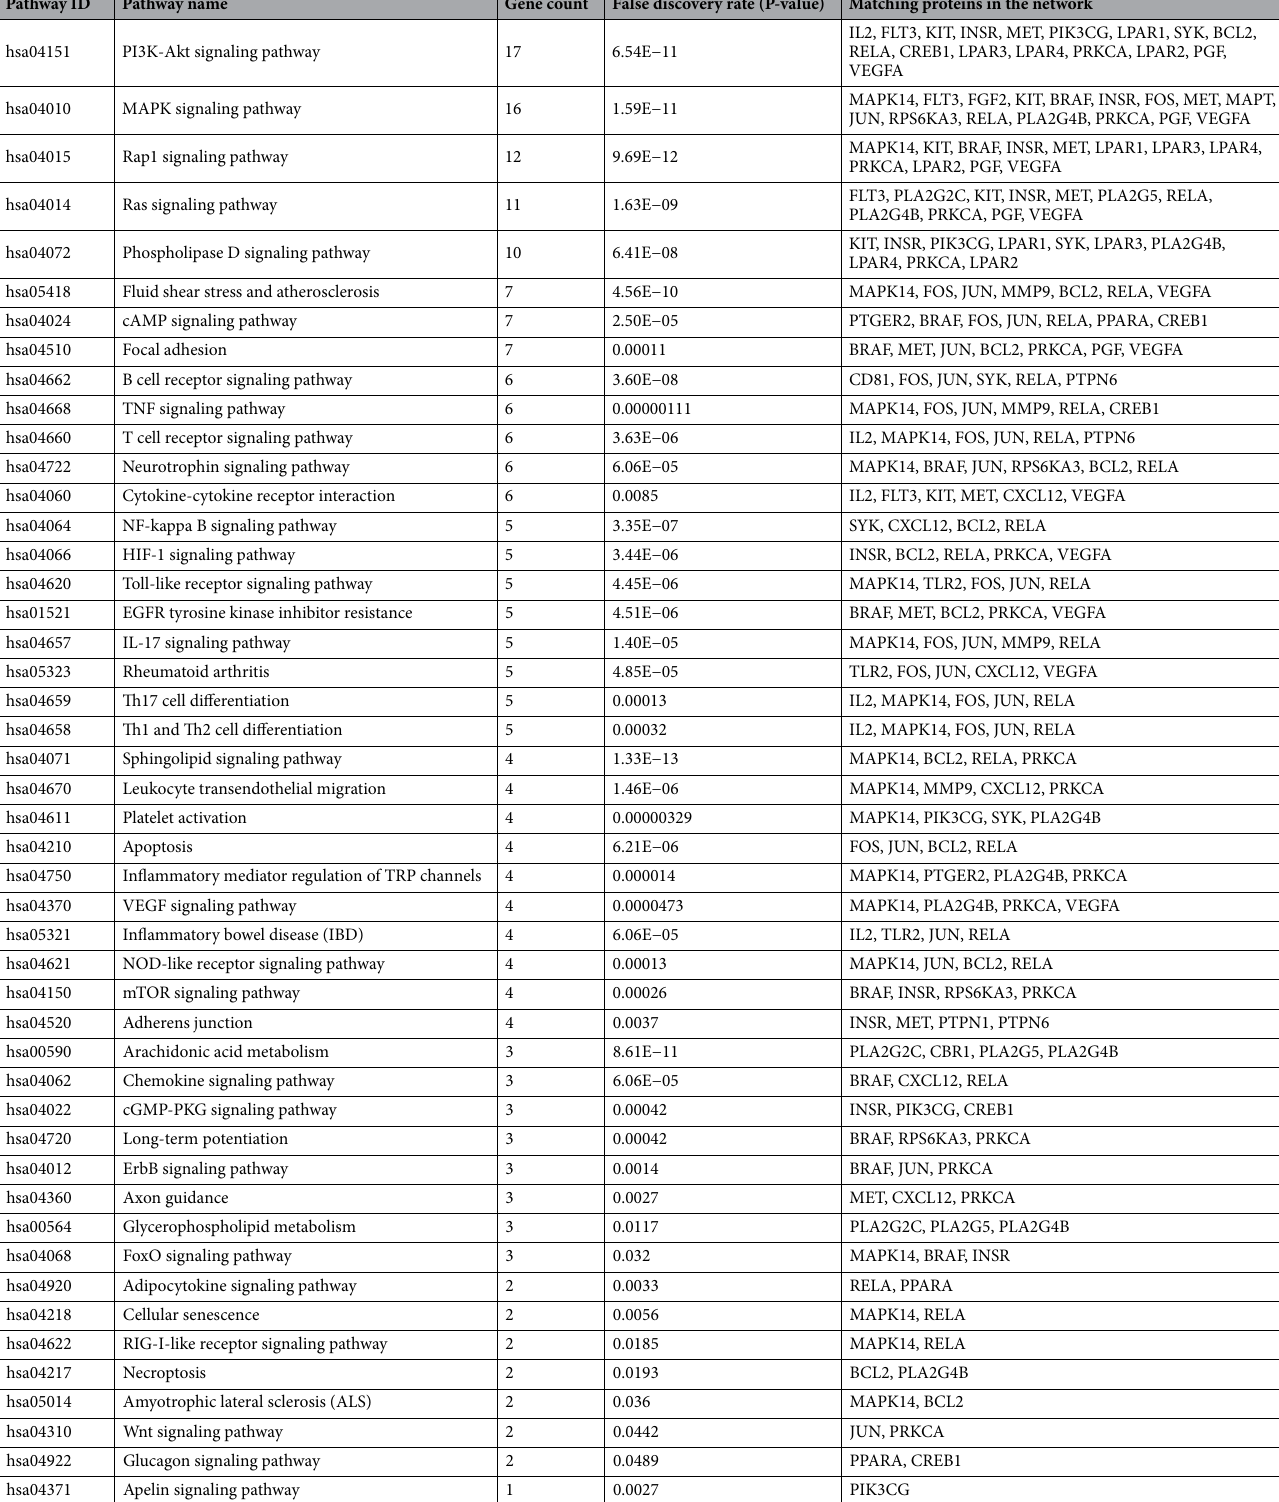
Table 3. KEGG pathway analysis of potential target genes